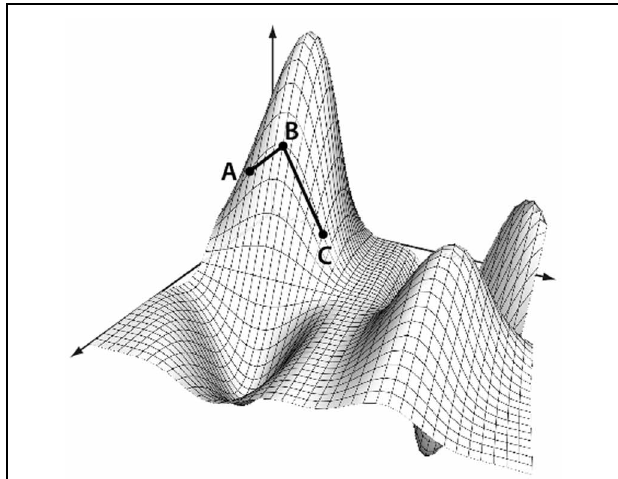
FIGURE 5 | Geodesic distance calculation. The distance between A and C is calculated as the manifold path distance from A to B to C, instead of the direct path from A to C. This eliminates the assumption that the points occupy a linear space when using a Euclidean distance.